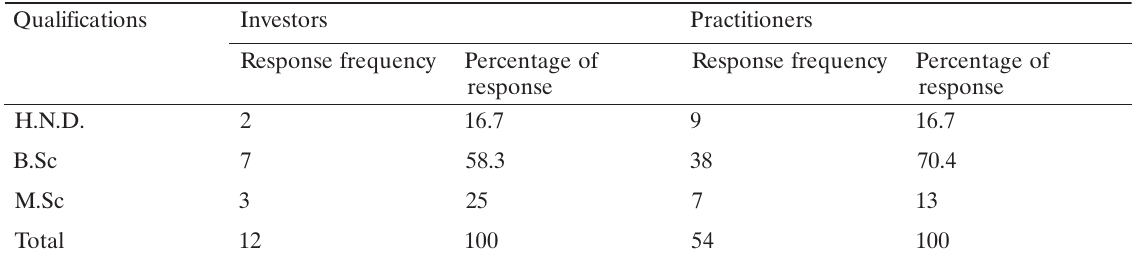
Source: Field data analysis,